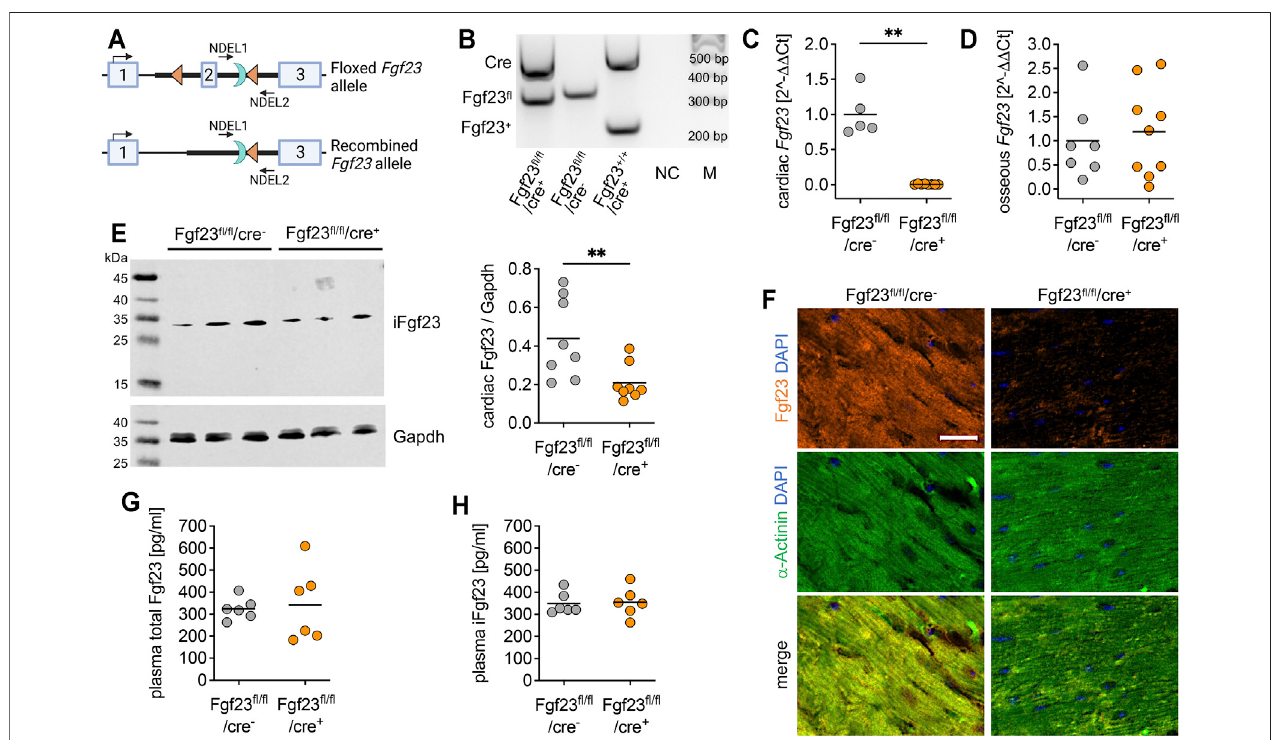
FIGURE 2 | Characterization of the cardiac myocyte-speci fi c Fgf23 knockout mouse. (A) Schematic illustration of CreLoxP strategy to generate cardiac myocyte- speci fi c Fgf23 knockout showing murine Fgf23 allele with exons 1-3 and location of LoxP sites (triangles) surrounding exon 2 as well as the remaining Flp recognition target site (half-moon). Positions of PCR primer for genotyping are marked with NDEL1 and 2. Top: fl oxed Fgf23 allele, bottom: Fgf23 allele after Cre-mediated recombination(generated withBioRender.com). (B) RepresentativeagarosegelofgenotypingPCRdemonstratingPCRproductsforwild-type(Fgf23 + ;253bp)or fl oxed(Fgf23 fl ,367bp) Fgf23 alleleandCre(550bp),anon-templatecontrol(NC),and100-bpDNAladder(M). (C,D) Quantitativereal-timePCRanalysisrevealsalmost undetectable cardiac, but unchanged osseous Fgf23 mRNA in Fgf23 fl / fl /cre + compared to Fgf23 fl / fl /cre − control mice. (E) Representative immunoblot and respective quanti fi cation show signi fi cantly reduced Fgf23 protein levels in total heart lysates of Fgf23 fl / fl /cre + compared to Fgf23 fl / fl /cre − control mice. Gapdh serves as loading control. (F) Immuno fl uorescence co-staining for Fgf23 (orange) and α -Actinin (green) with cell nuclei (blue) demonstrates lacking Fgf23 protein expression in cardiac myocytes of Fgf23 fl / fl /cre + mice compared to Fgf23 fl / fl /cre − controls. Magni fi cation × 20, scale bar 20 µm. (G) Plasma total Fg23 and (H) intact Fgf23 (iFgf23) concentrations in Fgf23 fl / fl /cre + mice are comparable with respective Fgf23 fl / fl /cre − controls. Data is given as scatter dot plots with means; ** p < 0.01 analyzed